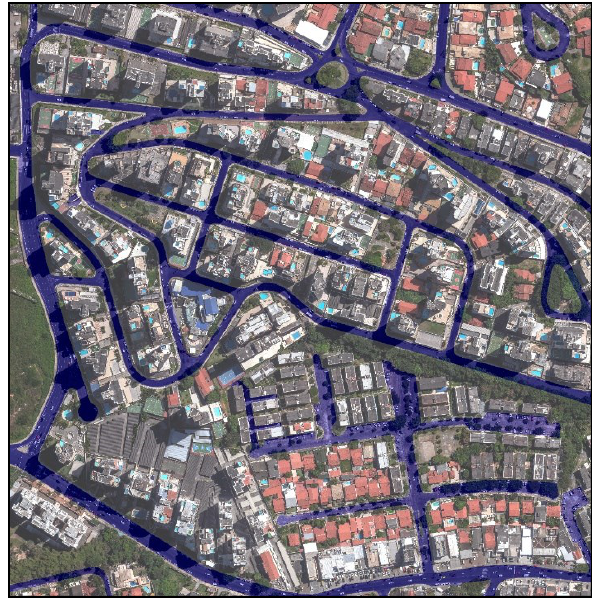
Figure 1 . Itaigara neighborhood with road network in